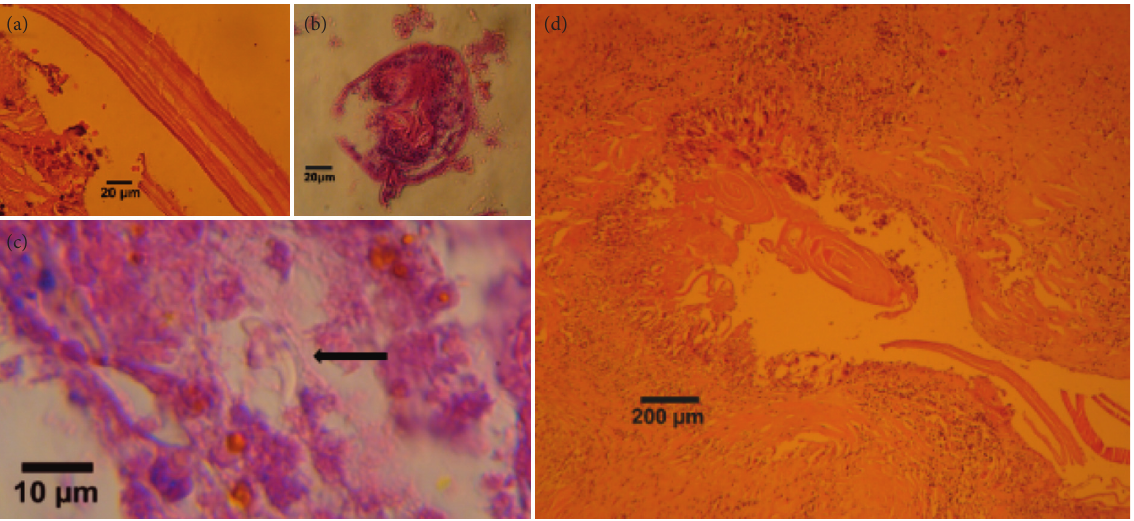
Figure 2: Section of hydatid cyst stained with H&E. (a) Laminated membrane. (b) Protoscolex (with hook and calcareous body). (c) Hooklet. (d) Destruction of liver parenchyma by the hydatid cyst and replacement by fibrosis and giant cell. Table 1: Comparison of the laboratory data including blood and sera tests, during pre- and postsurgery times shows the differences. Presurgery Surgery Laboratory test